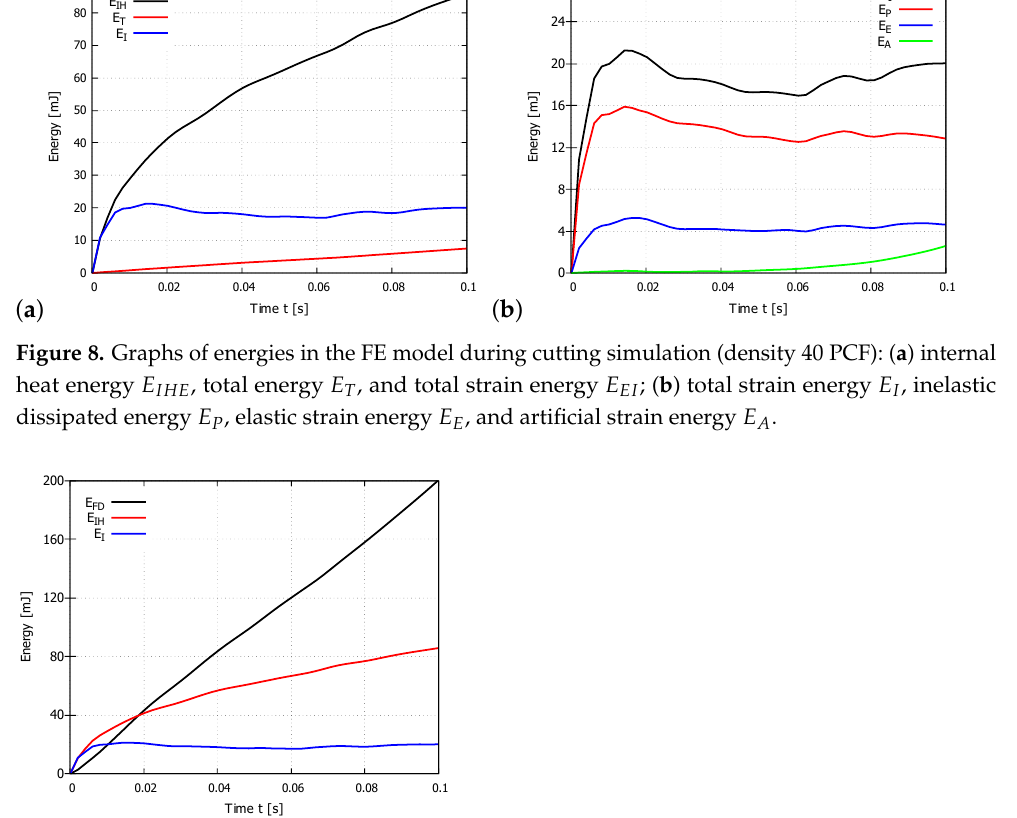
Figure 9. Graphs of frictional dissipated energy E FD , internal heat energy E IH , and total strain energy E I in the FE model during a cutting simulation with constant cutting speed of 500 mm/s and a sample density 40